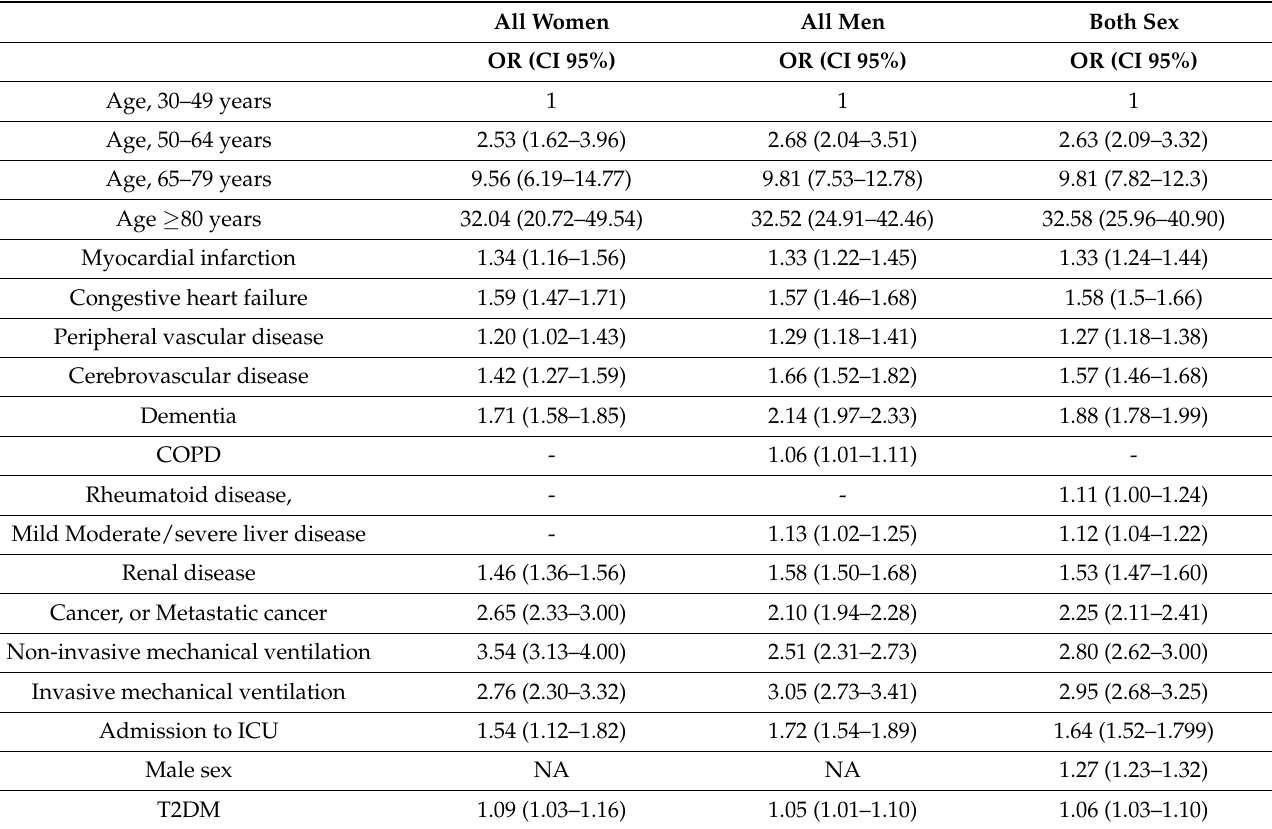
Table 6. Multivariable analysis of factors associated with in-hospital mortality in patients hospitalized with COVID-19 in Spain, 2020 according to